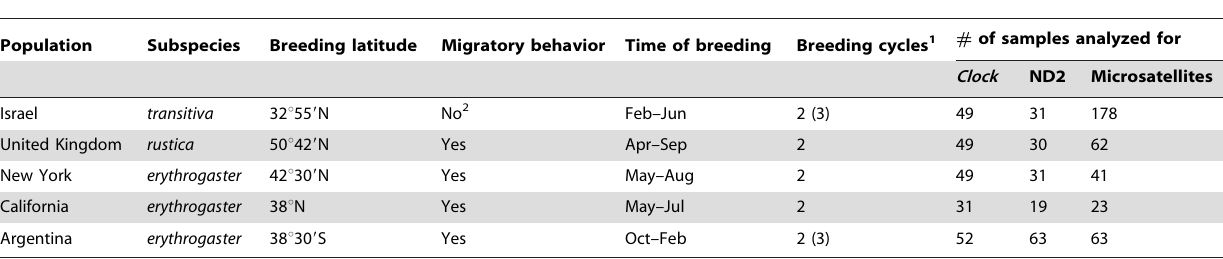
Table 1. Characteristics of the Barn Swallow populations used in this study with sample sizes for the genetic markers used in this